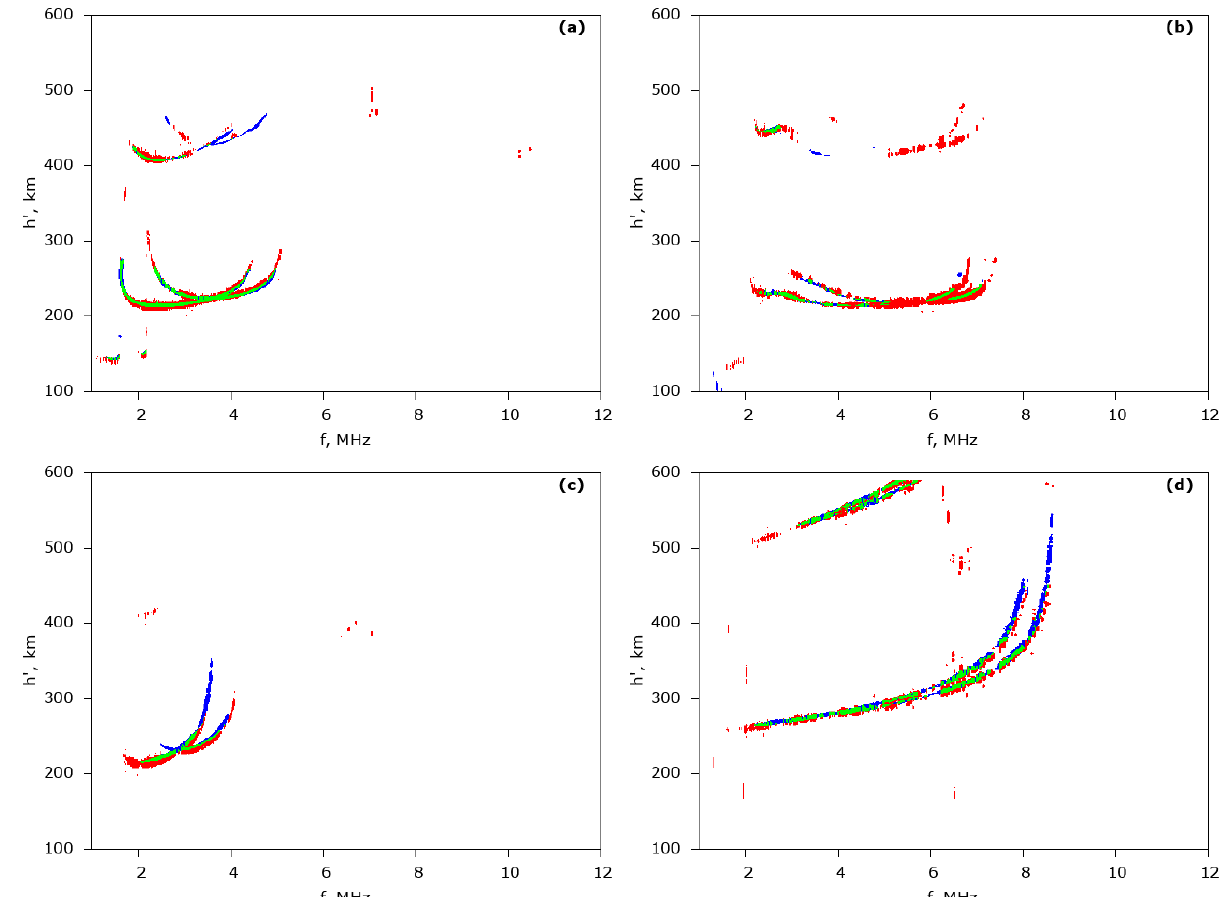
Figure 7. ( a ) Ionogram comparison images obtained at UAS by ISDR and IPS-42 on 12 April 2021 at 07:45 LT, ( b ) 6 May 2021 at 13:15 LT, ( c ) 4 May 2021 at 15:30 LT, and ( d ) 9 November 2021 at 23:00 LT. Pixels present on ISDR ionograms only are shown in blue, on IPS-42 ionograms only — in red, on both ionograms — in green. Additional information can be found in Supplementary Materials.